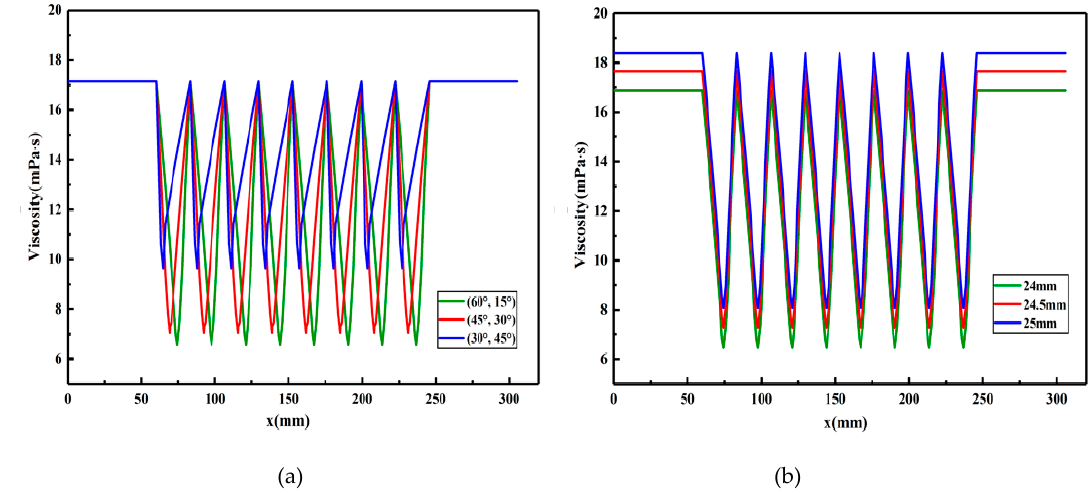
Figure 11. Viscosity curve of the polymer solution flowing through partial pressure tools with different structural parameters. ( a ) Front groove angle/rear groove angle. ( b ) Radius of the outer cylinder.